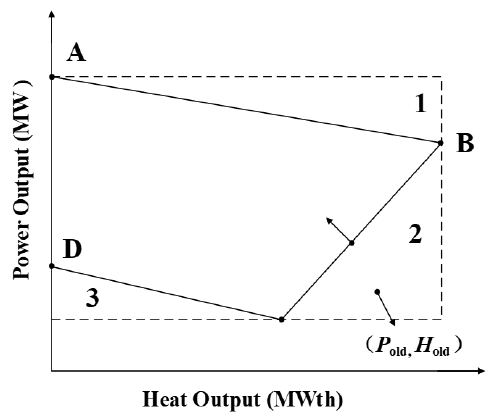
Figure 1. Typical feasible region of the cogeneration unit.